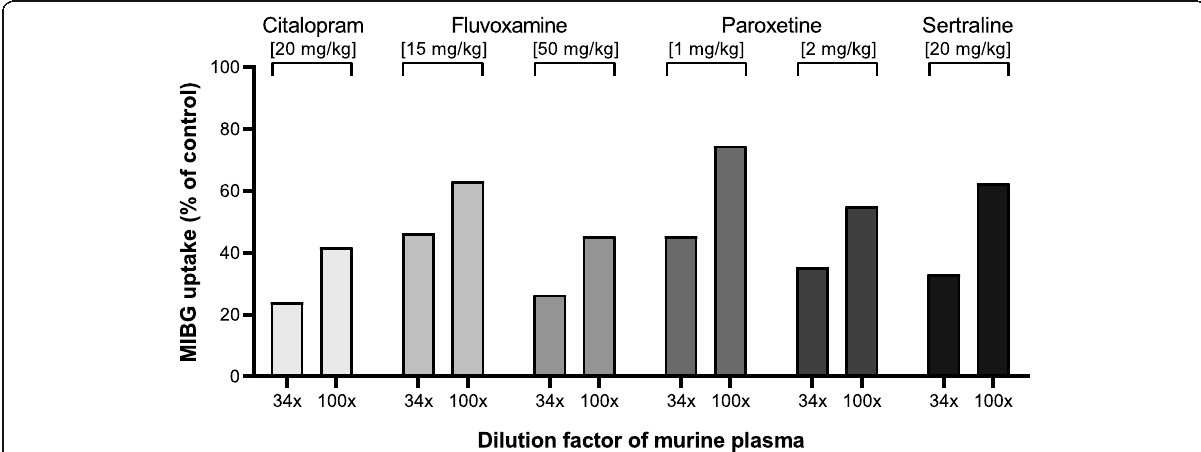
Fig. 7 Inhibition of [ 125 I]MIBG uptake in isolated human platelets by different dilutions of murine plasma obtained from SSRI-treated mice. One hour before collecting plasma, mice intraperitoneally received the monoamine transporter inhibitor at the dose indicated in parenthesis. Data are from a representative experiment performed in duplicate and were confirmed by at least 2 experiments performed at slightly different